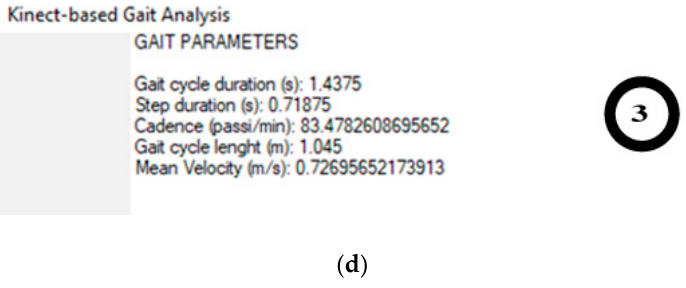
Figure 2. SANE (eaSy gAit aNalysis system) interface: ( a ) overview; ( b ) zoom-Area 1; ( c ) zoom-Area 2; ( d ) zoom-Area 3.